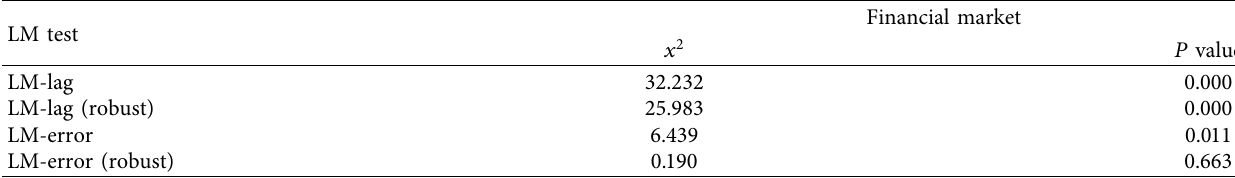
Figure 3: Spatial scatter plots of three-stage SE financial efficiencies in China’s 30 provinces in 2004, 2010, and 2016. Table 6: Empirical results of the Lagrangian multiplier (LM)